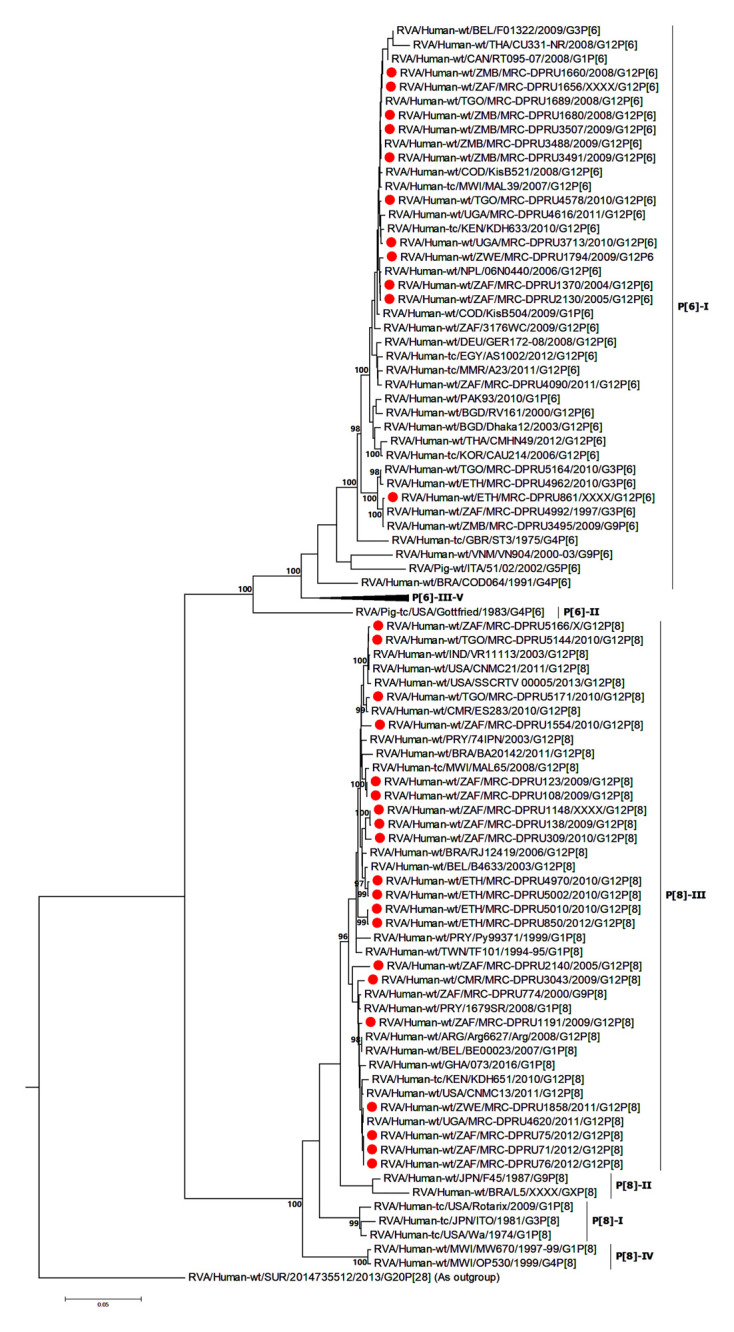
VP4 maximum likelihood tree general time reversible model with gamma distribution and invariant sites the tree. African G12 study strains shown in red. Bootstrap values of ≥75% are not shown. Scale bars, 0.05 substitutions per nucleotide.